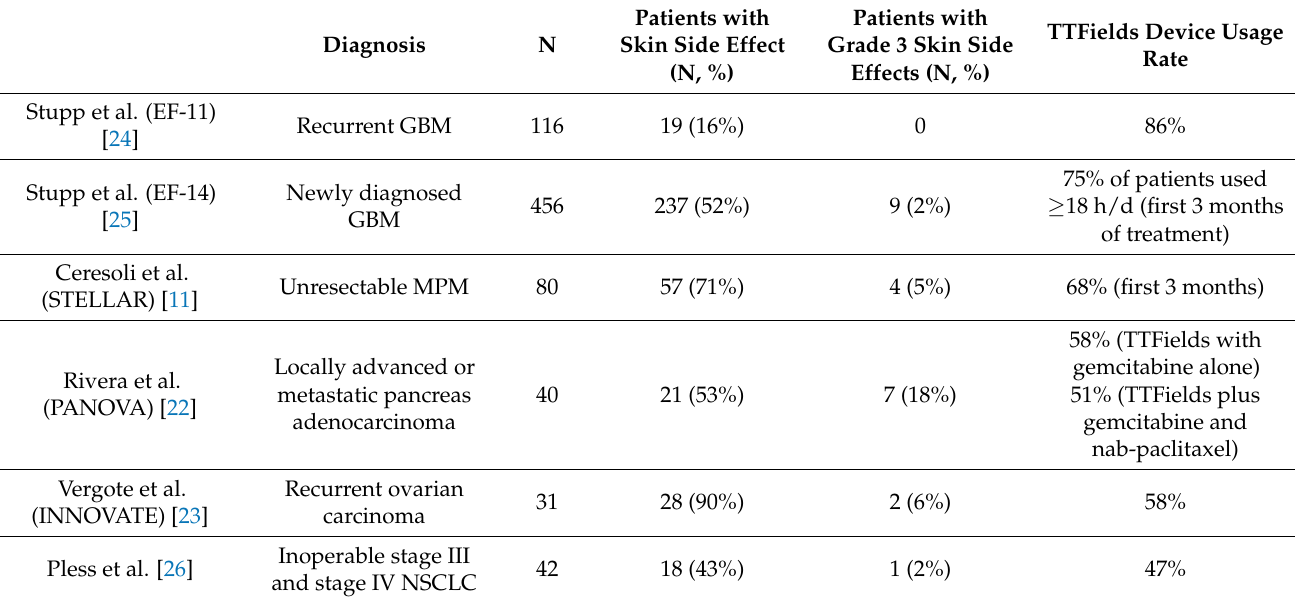
Table 3. Summary of the skin adverse events and usage rates of published clinical trials of TTFields in various disease